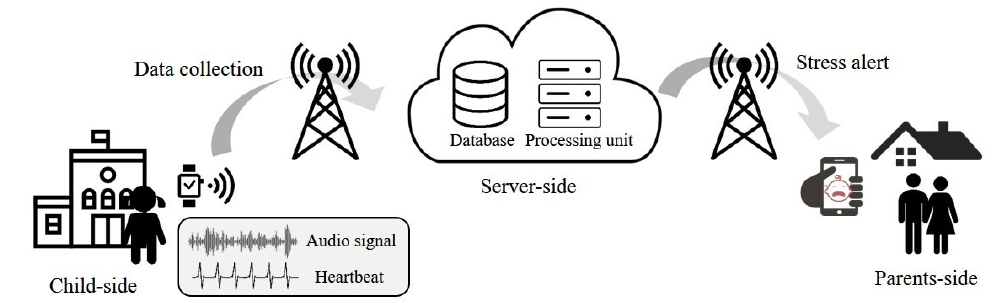
Figure 1. Framework of real-time stress monitoring for children using wearable